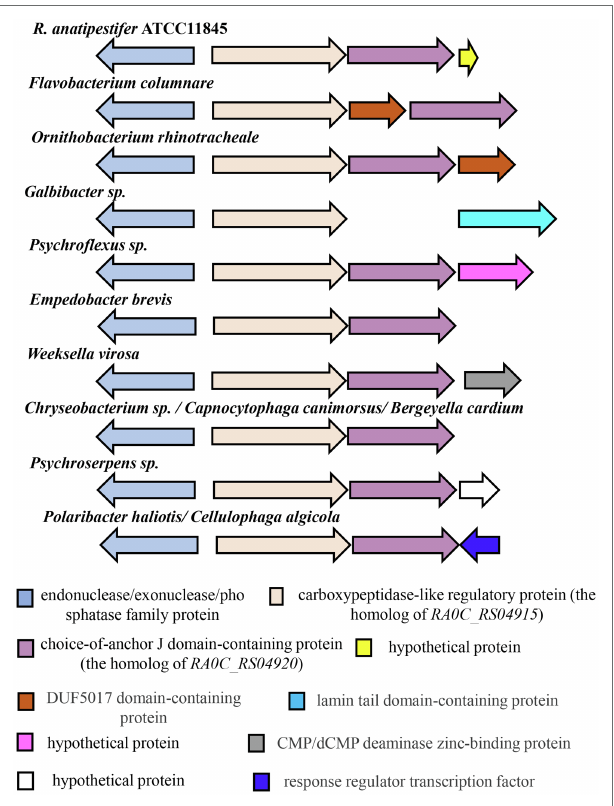
FIGURE 4 | Distribution of RA0C_RS04915 and RA0C_RS04920 in Flavobacteriaceae . The assay was performed by SyntTax (Footnote 3). The arrow indicates the location of the coding region and the direction of transcription for each gene. The same color in the figure shows corresponding homologs.